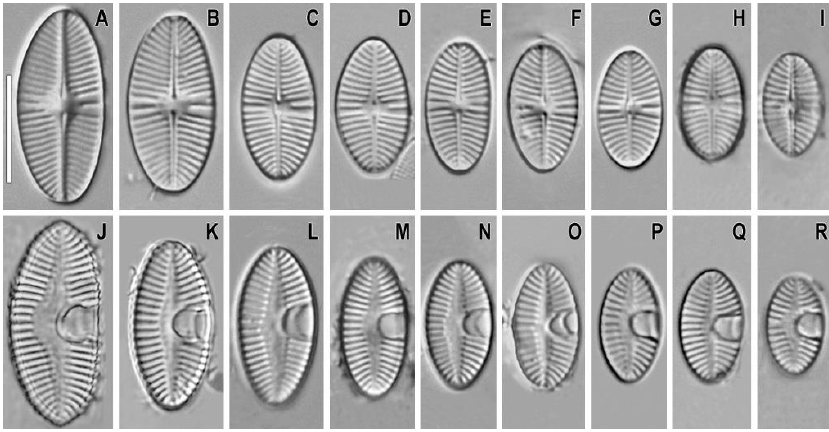
Figure 1. Planoplatessa joursacensis (Héribaud) Kulikovskiy, Glushchenko & Kociolek comb. nov. Slide no. 02605. Light microscopy, differential interference contrast, size diminution series. (A – I). Raphe valves . (J – R). Rapheless valves. Scale bar = 10 μm.